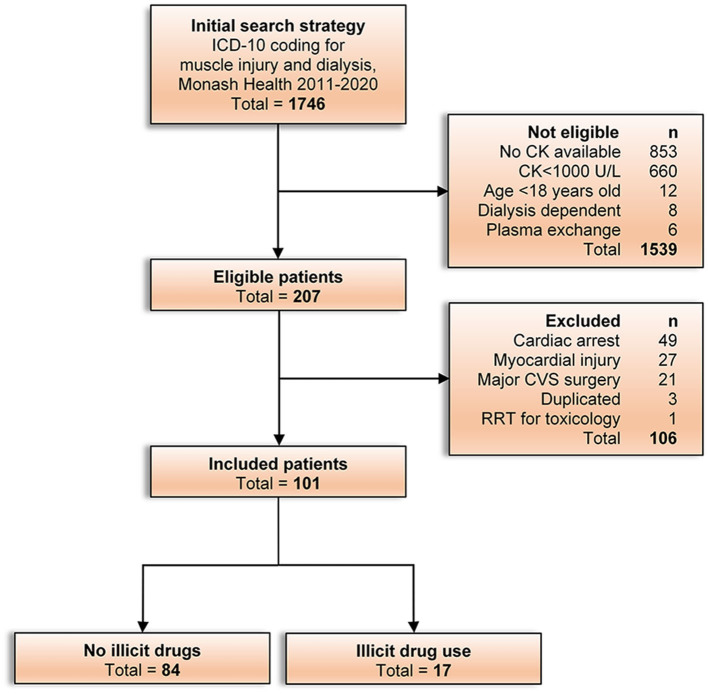
Study flow chart outlining the outcome of the ICD-10 search, assessment of eligibility, number and reasons for exclusions, and the final number of patients included for analysis.